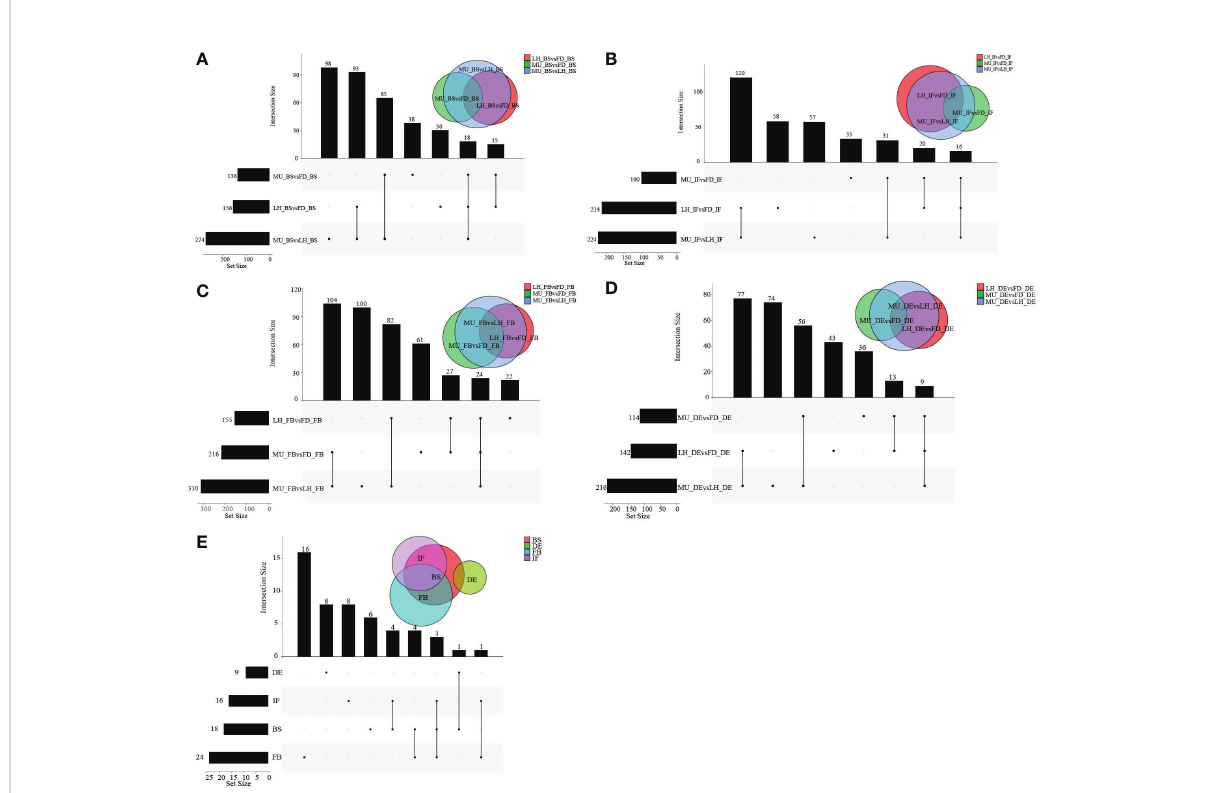
FIGURE 3 The distribution of DEMs across varieties at BS, IF, FB, and DE stages. (A) The distribution of DEMs across tree peony varieties (FD, MU and LH) at BS libraries. (B) The distribution of DEMs across tree peony varieties (FD, MU and LH) at IF libraries. (C) The distribution of DEMs across tree peony varieties (FD, MU and LH) at FB libraries. (D) The distribution of DEMs across tree peony varieties (FD, MU and LH) at DE libraries. (E) The distribution of intersection DEMs across tree peony varieties (FD, MU and LH) and across four fl ower developmental stages (BS, IF, FB,